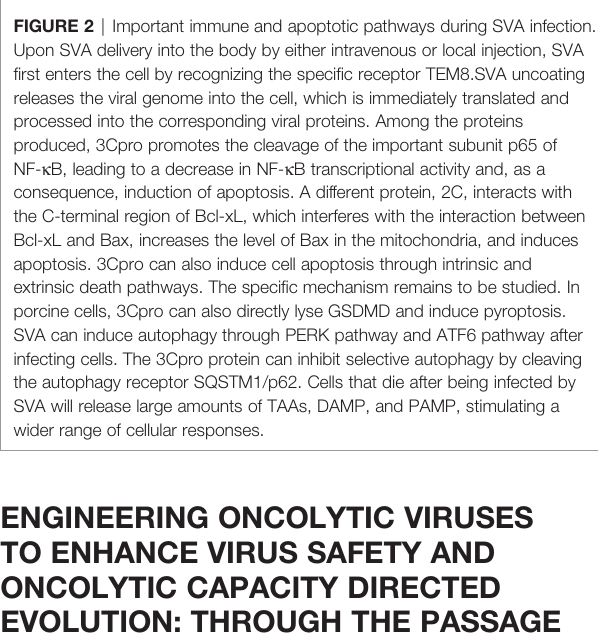
FIGURE 3 | Engineering oncolytic viruses to enhance virus safety and oncolytic capacity. (A) Directed evolution: through the passage of virus in speci fi c tumor cells, a comparison of oncolytic ef fi cacy and toxicity of parental viruses and their variants in vivo and in vitro , or comparison of gene sequencing or screening viruses that are adaptable to tumor cells, can improve the selectivity of the viruses to tumor cells. (B) Oncolytic virus is a powerful vector that loads the interest gene like cytokines, tumor peptides, or nanobodies into the viral genome by genetic engineering. In this system, the OV carries these foreign genes into the host cell for expression and exert their biological functions. (C) The necessity and strategic combinations of an oncolytic virus with chemotherapy and other biological strategies. (D) Oncolytic virus encoding reporter genes for in vivo molecular imaging.